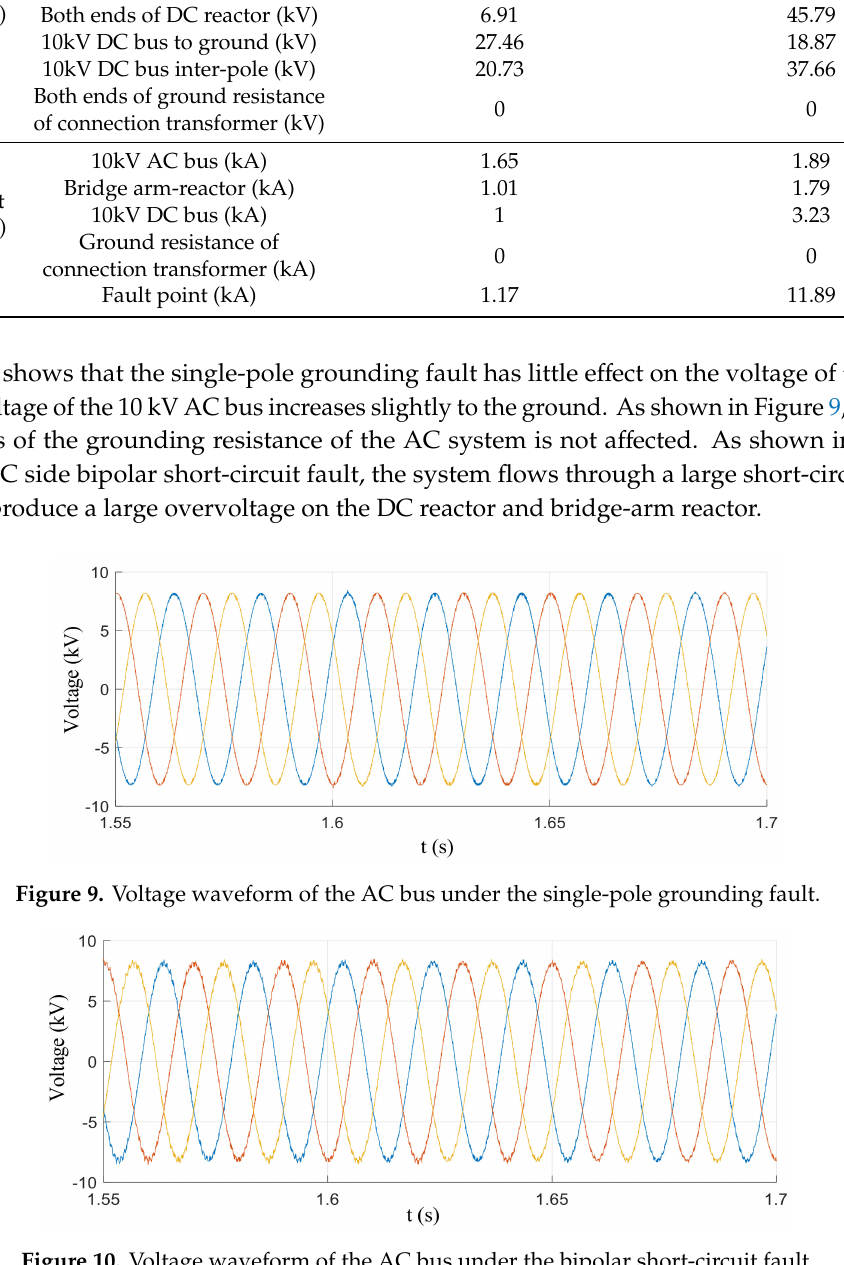
Figure 10. Voltage waveform of the AC bus under the bipolar short-circuit